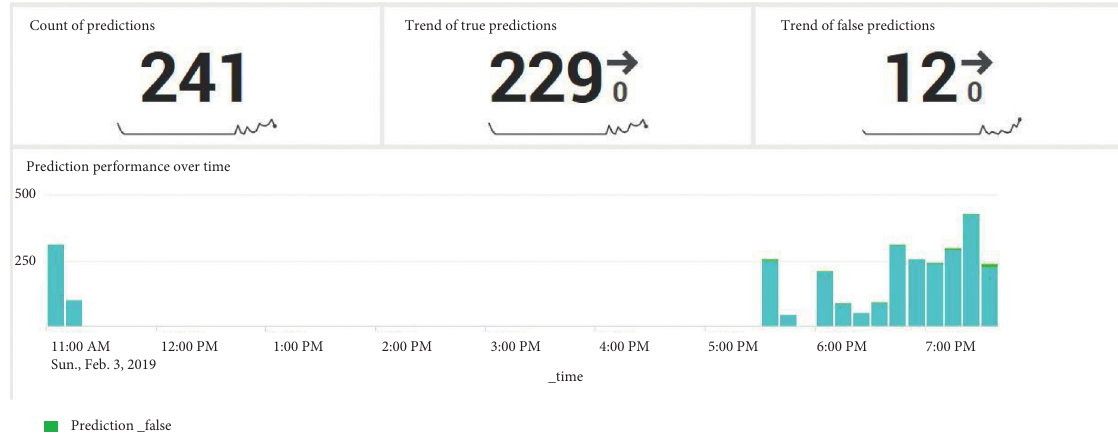
Figure 20: Process of true and false predictions for decision tree algorithm.